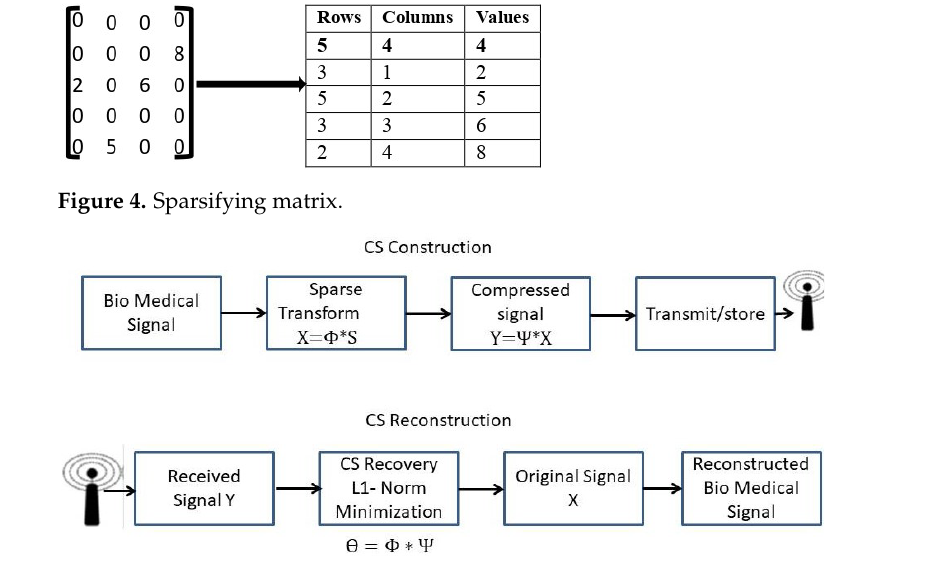
Figure 5. Communication framework using CS.